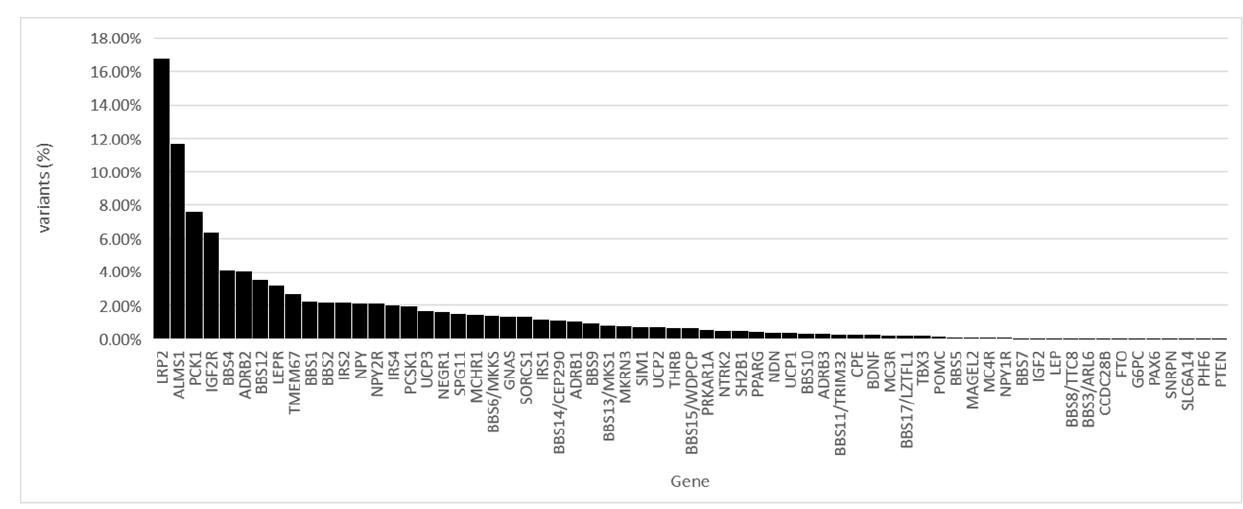
Figure 2. Percentage of samples where variants were detected, by gene. The Y axis represents the percentage of samples with variability, and the X axis the name of the genes.